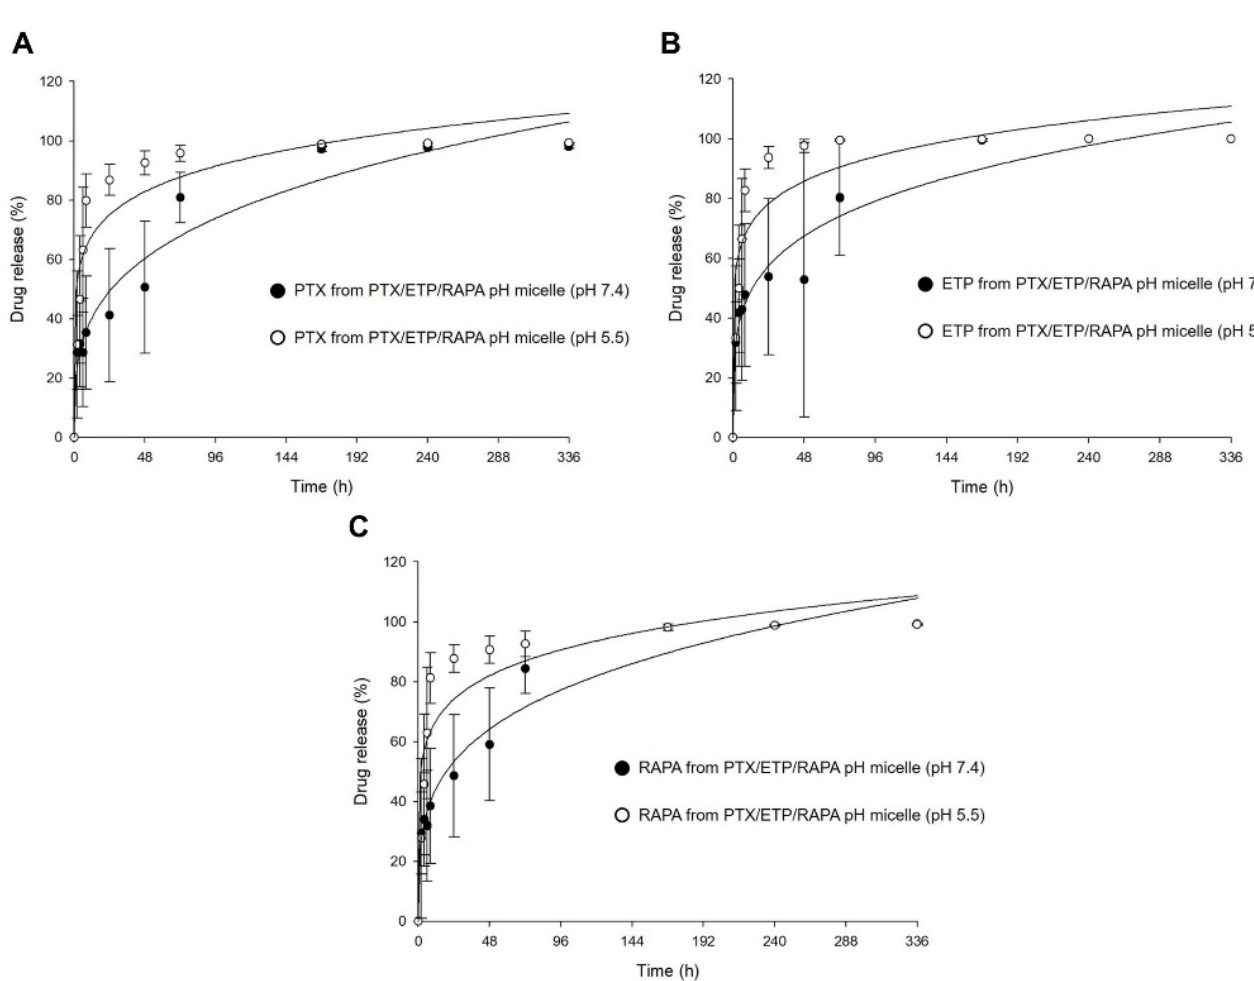
Table 4. Pharmacokinetic parameters of paclitaxel (PTX), etoposide (ETP), and rapamycin (RAPA) in PTX/ETP/RAPA-loaded mPEG-pH-PCL micelles and PTX/ETP/RAPA solution after intravenous injection (n = 3).